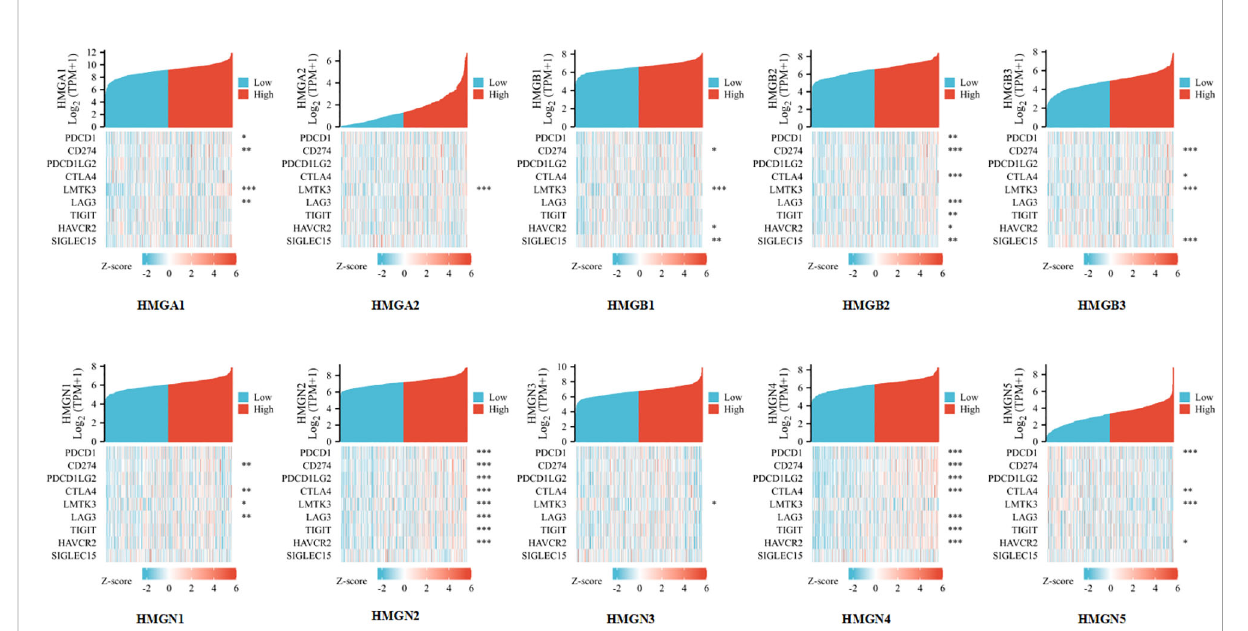
FIGURE 10 Relevance analysis of immune checkpoint-related genes and HMGs in GC (*p< 0.05; **p<0.01;